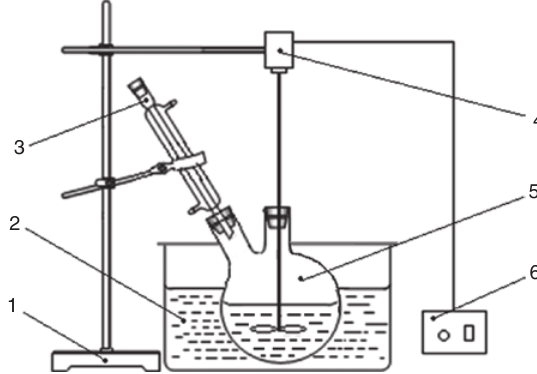
Figure 1: Schematic diagram of homogeneous precipitation experimental